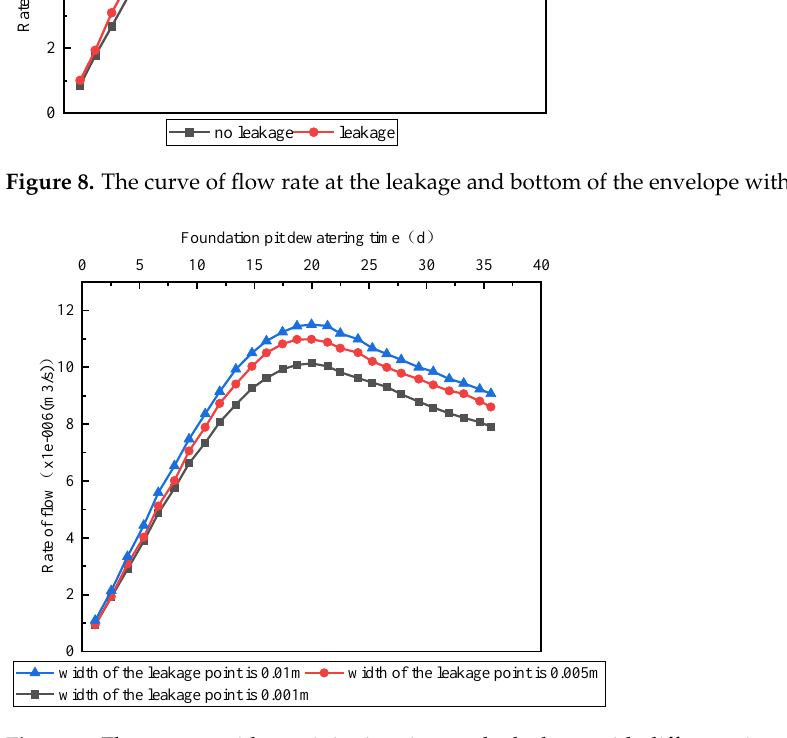
Figure 9. Flow curve with precipitation time at the leakage with different sizes.